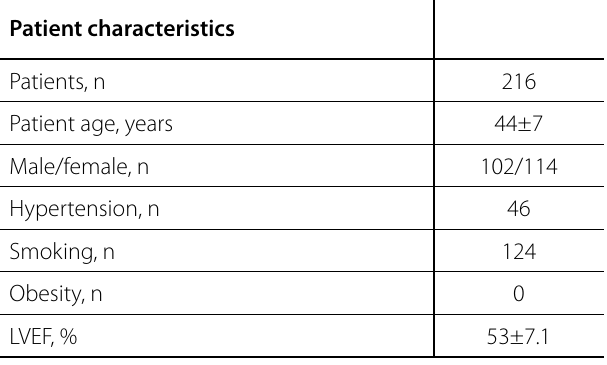
Table 1. Demographic parameters of patients who underwent robotic cardiac surgery with U-suture peripheral cannulation.